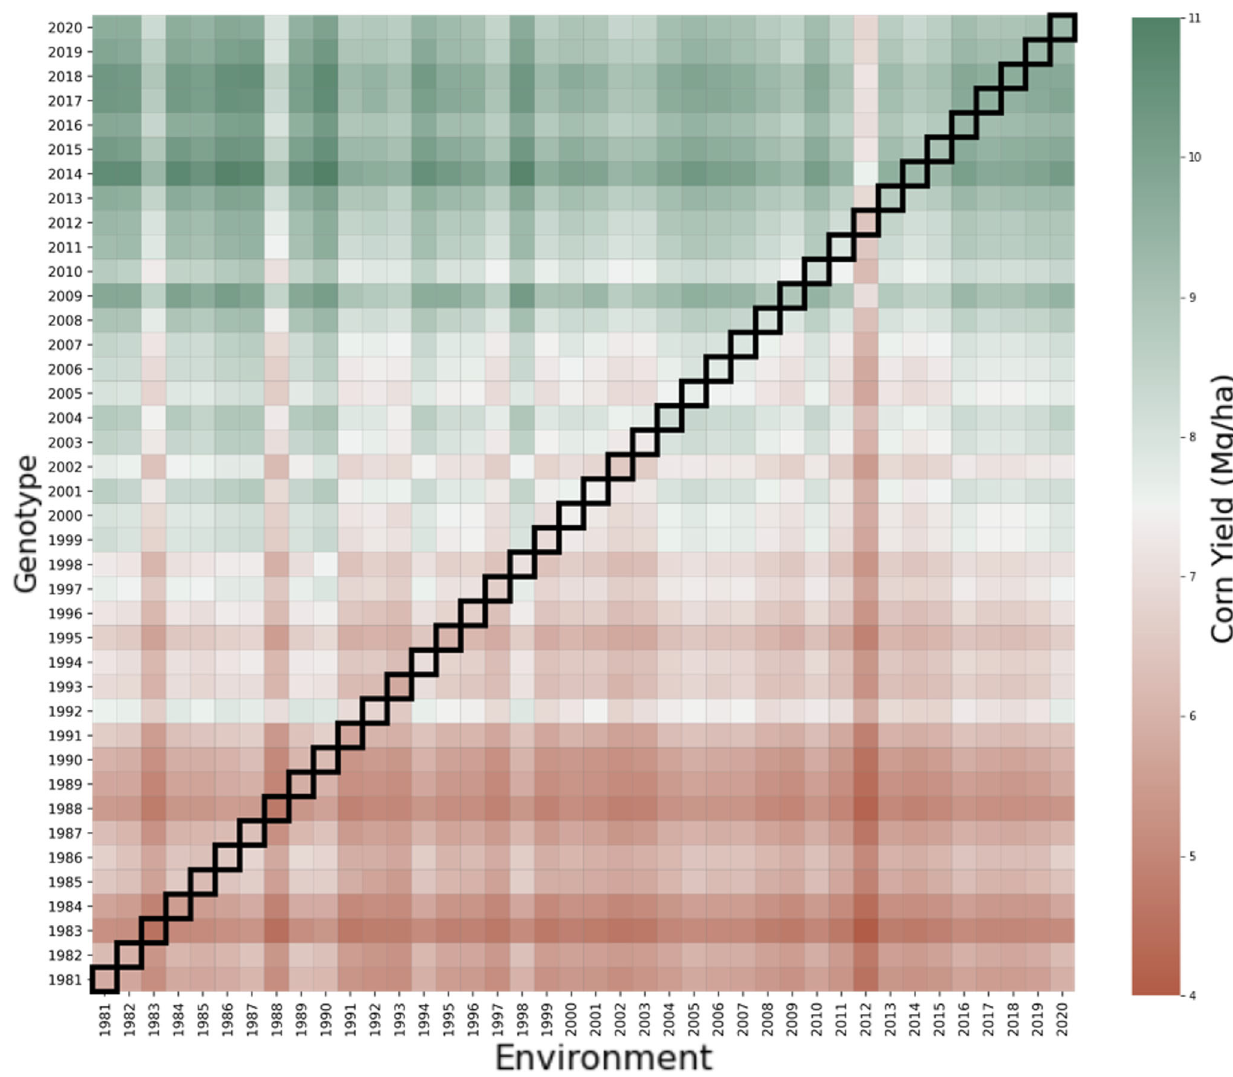
Fig. 5 Genotype by environment interactions result. Each colored square in the heat map indicates the predicted yield using the data-driven crop model when the genotype in the year from its corresponding vertical axis was grown in the environmental conditions in the year from its corresponding horizontal axis.